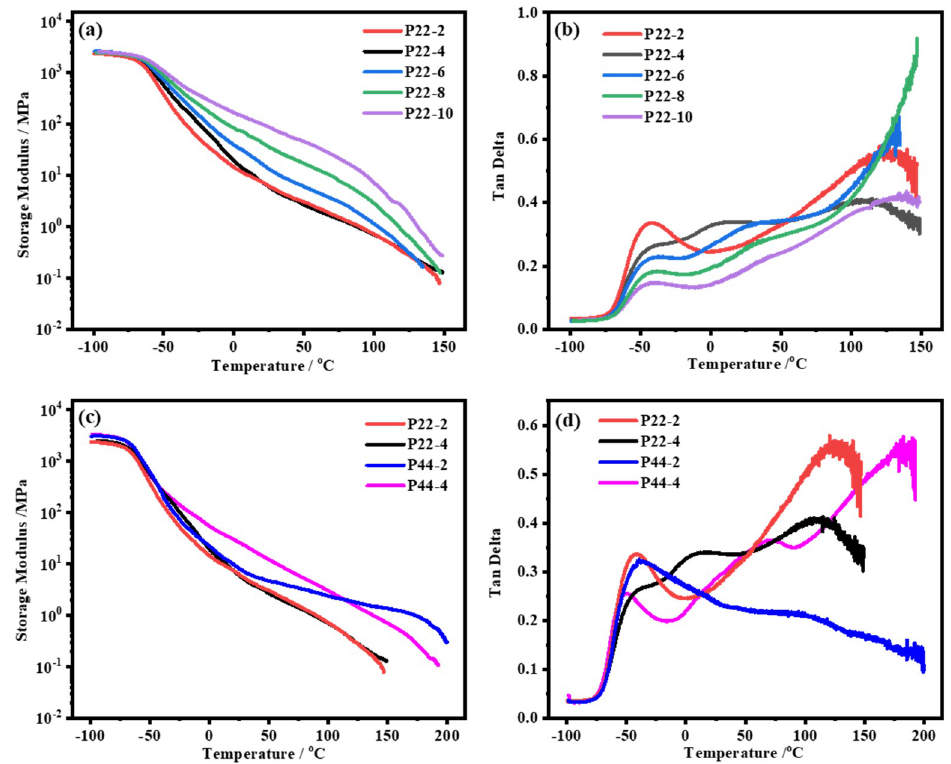
Figure 4. Dynamic mechanical analysis (DMA) temperature curves of the P22 and P44. The storage modulus (E’) plots are shown in ( a ) and ( c ), while the loss factor (tanδ) plots are shown in ( b ) and ( d ).